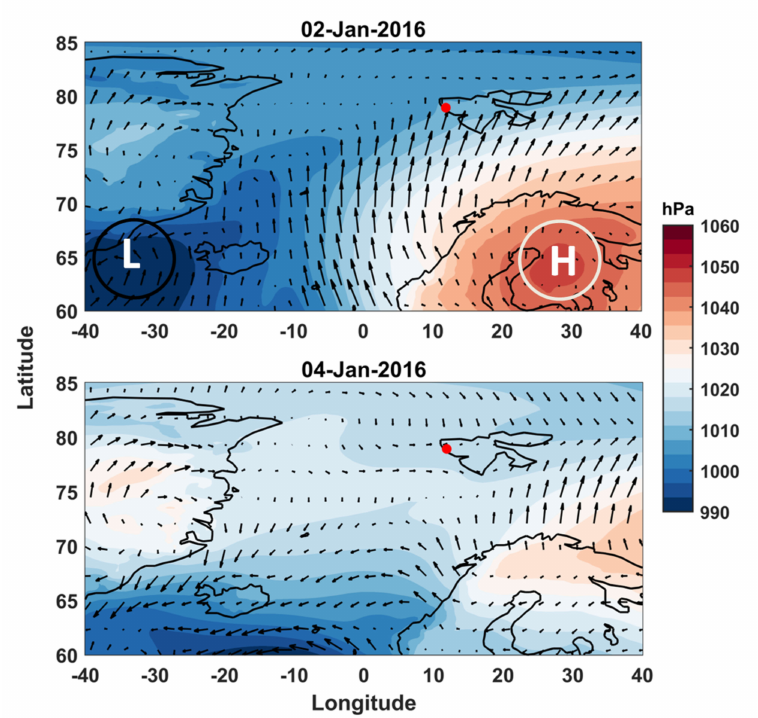
Figure 13. The ERA5 850 hPa winds overlaid on mean sea level pressure (MSLP) for a heavy rainy day ( top panel ) and light rainy day ( bottom panel ). The red mark is assigned for the station